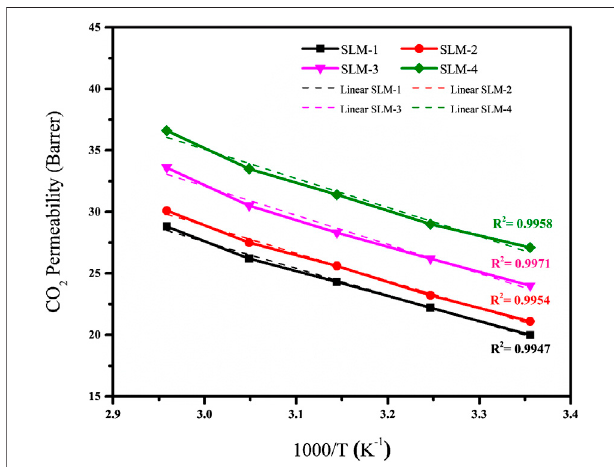
FIGURE 4 | Arrhenius plot of temperature and CO 2 permeability.